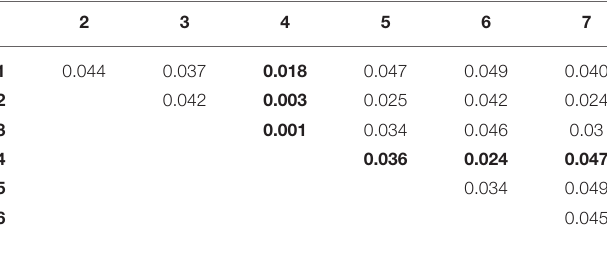
TABLE 4 | Significance test between different pair of feature types.